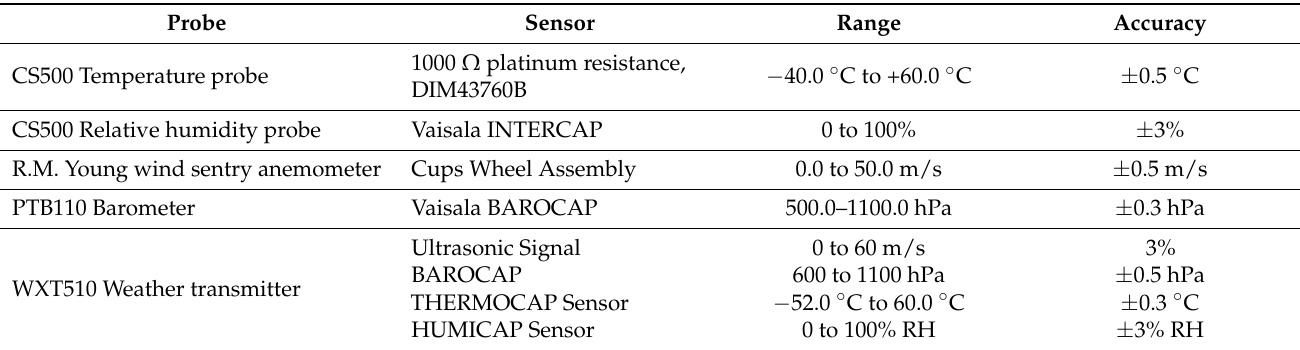
Table 1. Characteristics of the meteorological